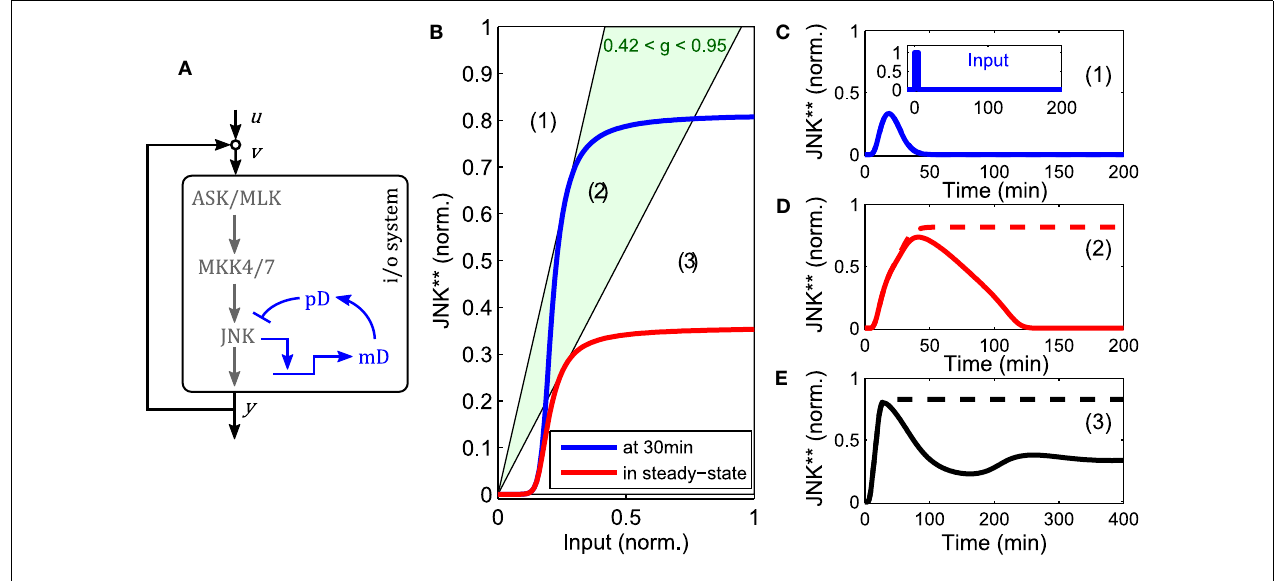
feedback takes effect. Red: steady state i/o characteristic. (C–E) Trajectories of the JNK response after stimulation with a transient pulse of 3min ( u ( t ) = 1 for 0 < t < 3) for different feedback strengths: (C) g = 0, (D) g = 0.7, (E) g = 1.5. Dashed lines indicate the responses without negative feedback, solid lines with negative